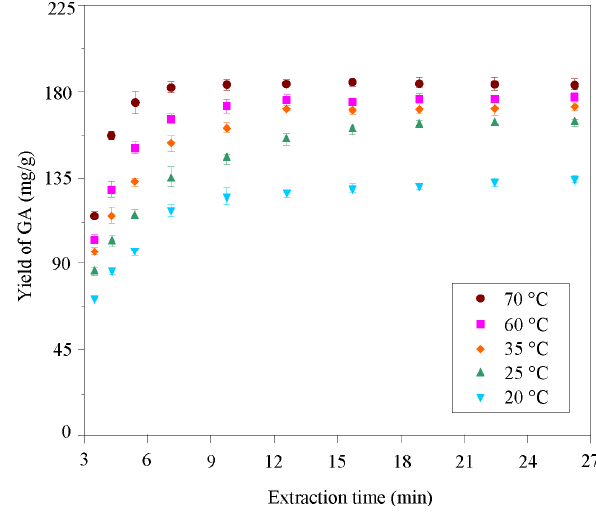
Figure 3. Evolution of extraction yields of glycyrrhizic acid with different extraction temperatures at ultrasonic frequency of 20 kHz and ultrasonic power of 125 W.